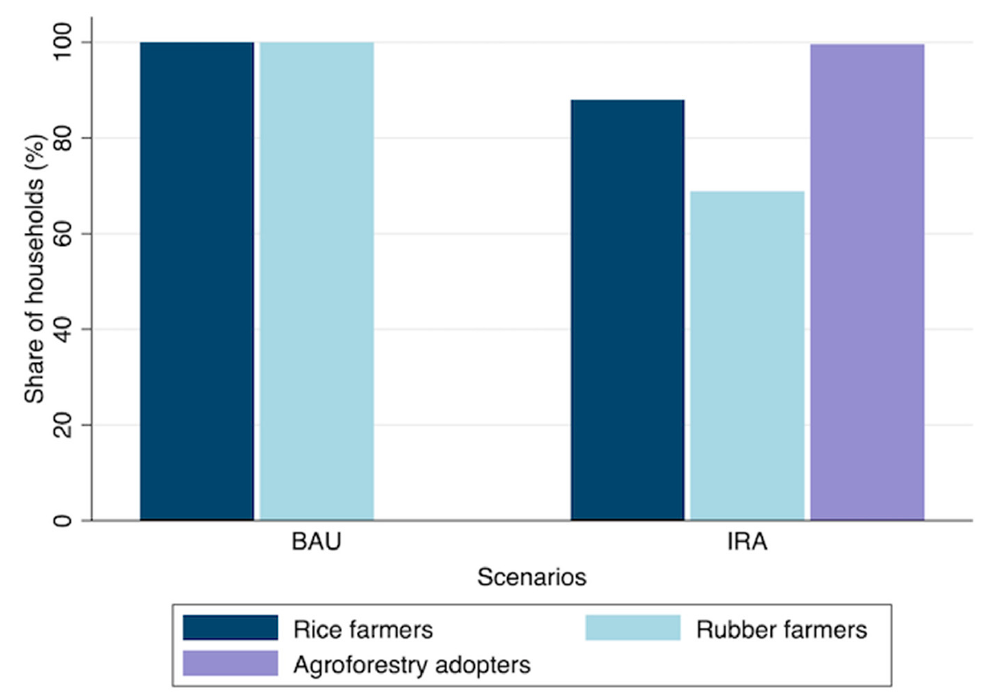
Figure 6. Simulation results: farmers’ livelihood choices.